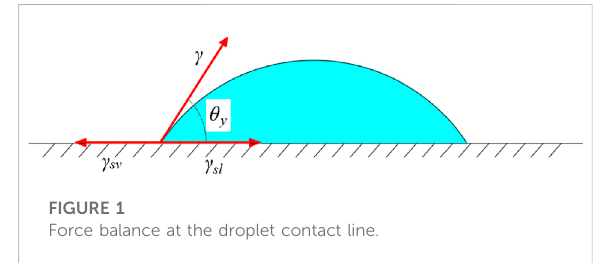
FIGURE 1 Force balance at the droplet contact